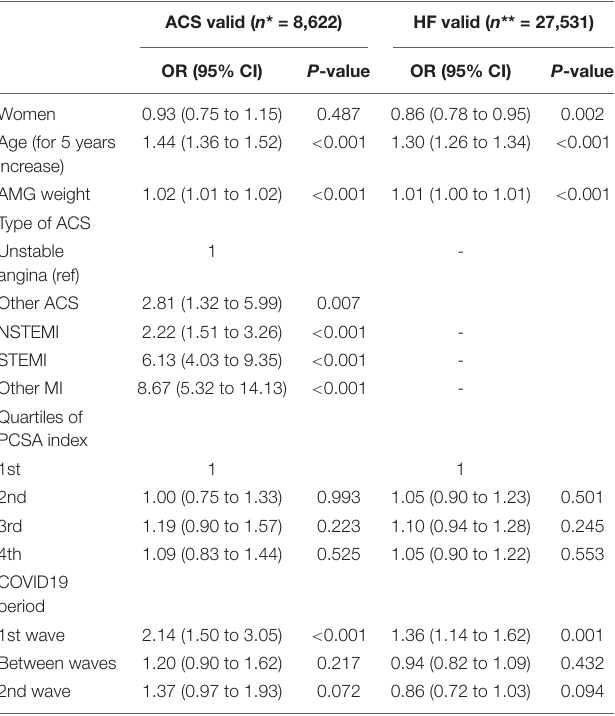
TABLE 3 | Association of patient characteristics and COVID-19 periods with in-hospital mortality for acute coronary syndrome (ACS) and heart failure